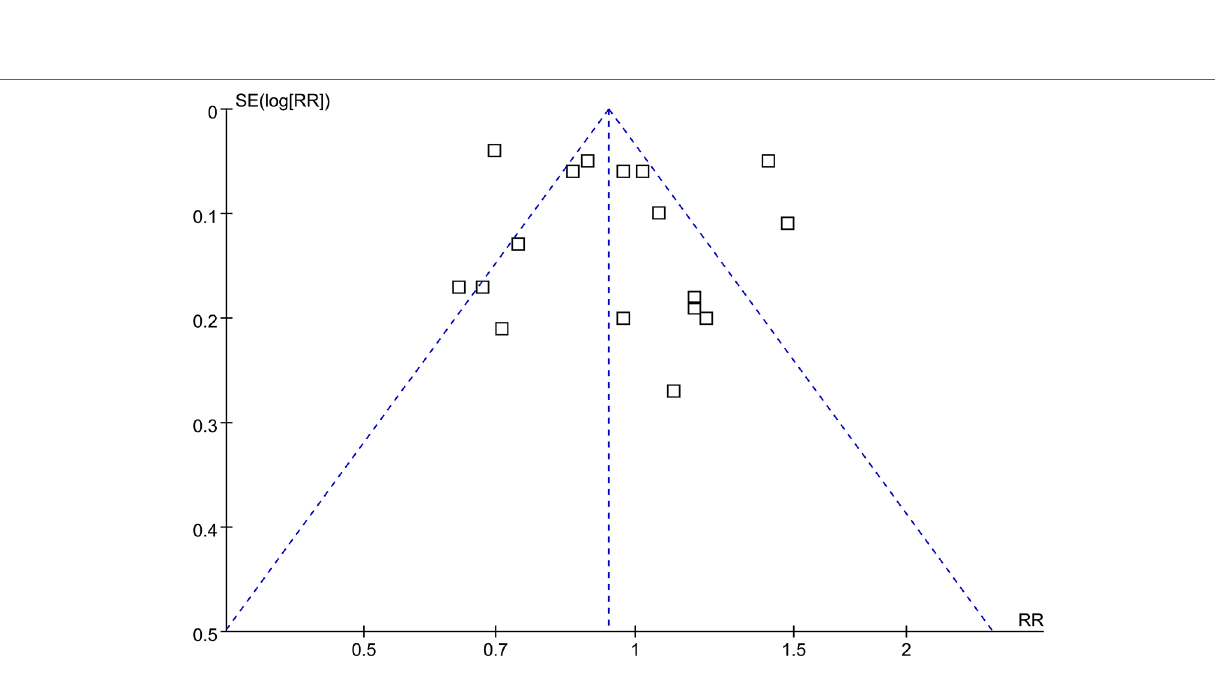
Frontiers in Pharmacology |